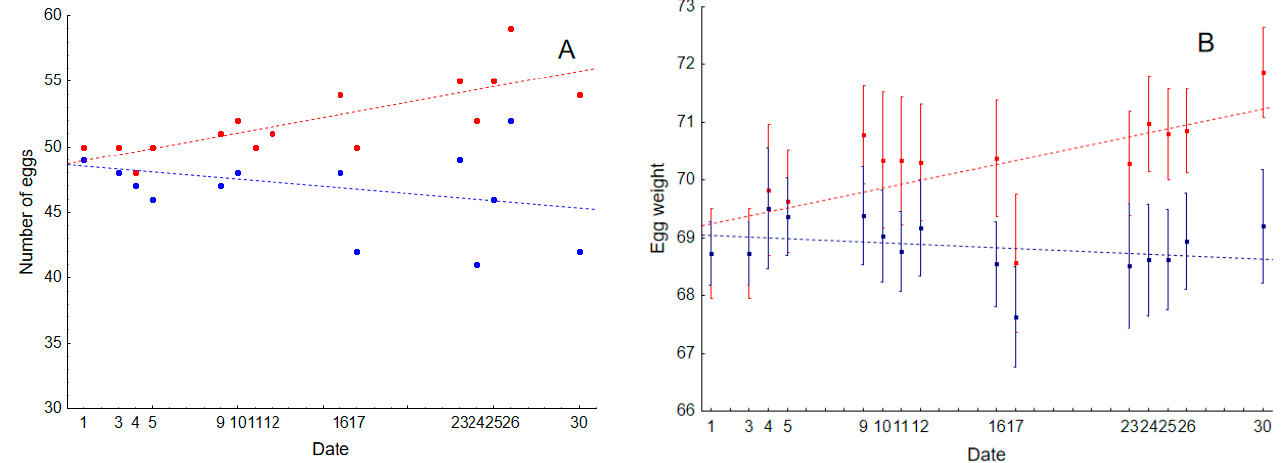
Figure 2. Changes in the number of eggs ( A ) and egg weight ( B ) produced by control laying hens (in blue) and laying hens experimentally supplemented with a commercial Alliaceae extract (in red) during 30 days of the experimental period. Regression lines and 95% CI are also shown.